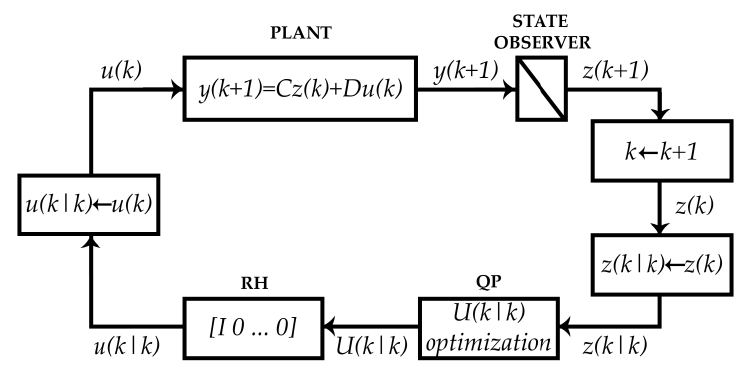
Figure 3. MPC algorithm loop and plant interaction.